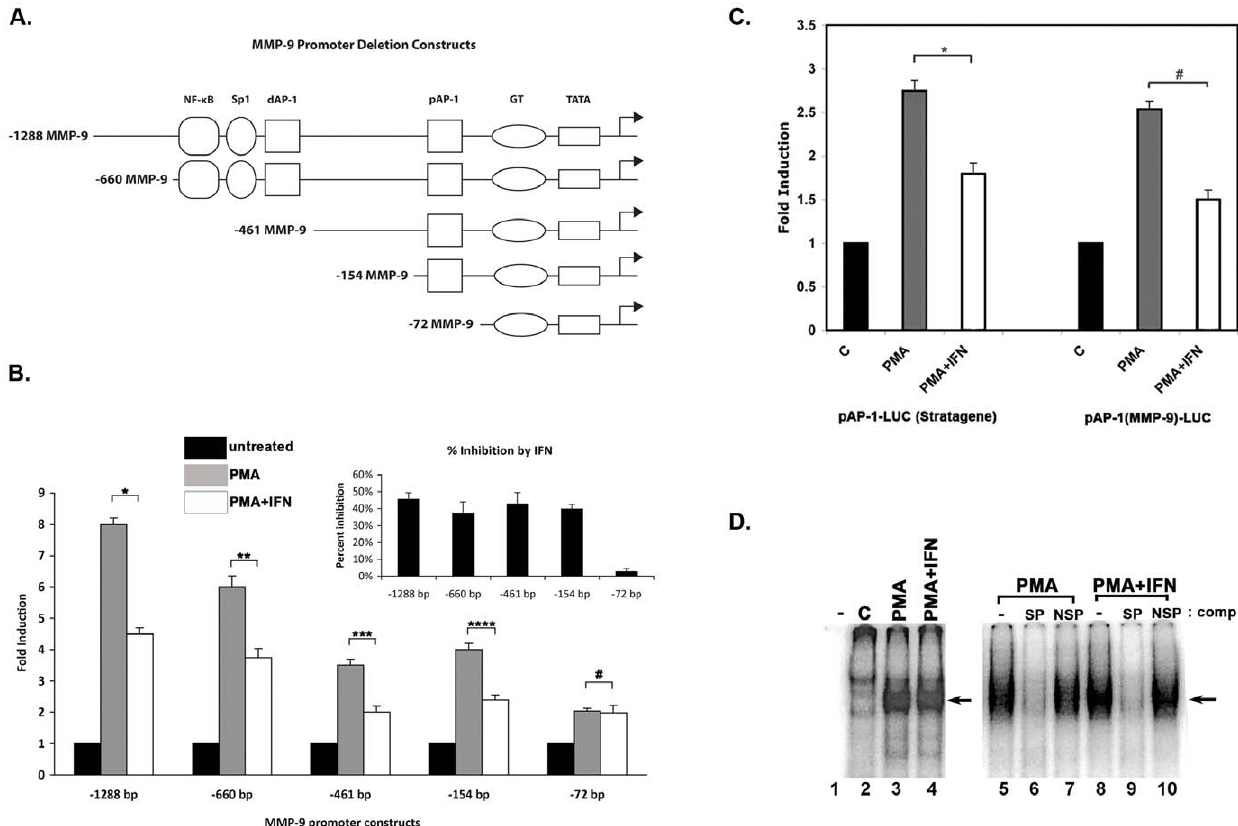
Figure 1. The -154 bp promoter construct retains the ability to respond to IFN b . (A) Schematic diagram of the deletion constructs. Progressive deletions of MMP-9 promoter were created by PCR amplification with appropriate primers. Various transcription factor binding sites and the TATA box are as indicated. (B) Mapping the promoter region responsible for IFN b mediated transcriptional repression. HT1080 cells were transiently transfected in 6 well plates in triplicates with MMP-9 promoter deletion constructs as indicated using Effectene transfection reagent (Qiagen). A plasmid encoding Renilla luciferase (pRL-null, Promega) was co-transfected for the normalization of transfection efficiencies. 24 hours after transfection, the cells were treated with 30 nM PMA and 100 U/mL IFN b for 18 hours prior to preparation of cell extracts. Cell extracts were assayed for firefly and Renilla luciferase activities. Black bars indicate untreated values, considered as 1 for each construct. Grey bars indicate PMA treated values represented as fold inductions. White bars indicate PMA and IFN b treated values also represented as fold inductions. The values represent averages of triplicate samples from four different experiments for each construct and the error bars represent standard deviation. The P- values were calculated using statistical analysis software. As indicated above bars, *, **, ***, and **** symbols indicate P values that indicate significant difference (0.0009, 0.0007, 0.0008, and 0.0009 resp.) and the symbol # indicates a P value of 0.1216 (no significant difference) with significant values being , 0.01. Inset: The percent inhibition in response to IFN b is plotted for each deletion construct. (C) AP-1 binding site is sufficient to confer downregulation by IFN b on a synthetic reporter construct. HT1080 cells were co-transfected with either consensus AP-1 binding site concatamer (pAP-1-Luc, Stratagene) or MMP-9-specific AP-1 binding site concatamer (AP-1 (MMP9)-Luc) linked to a basal promoter-Luc, and a plasmid encoding Renilla luciferase (pRL-null, Promega). 24 hours after transfection, cells were treated with 30 g M PMA and 100 U/mL IFN b for 18 hours prior to preparation of cell extracts. Cell extracts were assayed for firefly and Renilla luciferase activities. Black bars indicate untreated cell values, considered as 1 for each construct. Grey bars indicate the PMA treated values represented as fold inductions. White bars indicate the PMA and IFN b treated values represented as fold inductions. The values are averages from three separate experiments and the error bards represent standard deviation. The P-values were calculated using statistical analysis software. As indicated above the bars, *symbol indicates a P value of 0.0008 (significant difference) and the symbol # indicates a P value of 0.0001 (significant difference), with significant values being , 0.01. (D) IFN b does not inhibit the DNA-binding activity of AP-1. EMSA was carried out using the nuclear extracts prepared from HT1080 cells that were untreated or treated with PMA, PMA plus IFN b for 30 minutes. 1 m g of nuclear extracts were incubated with the 32 P-labeled AP-1 (region 2 93 to 2 56 of MMP-9 promoter) probe. Arrows indicate AP-1 complex bound to DNA. Unlabelled specific (SP: AP-1 consensus sequence) and non-specific (NSP: TATA box consensus sequence) competitor oligonucleotides in 100-fold molar excess were utilized to confirm the identity of the bound